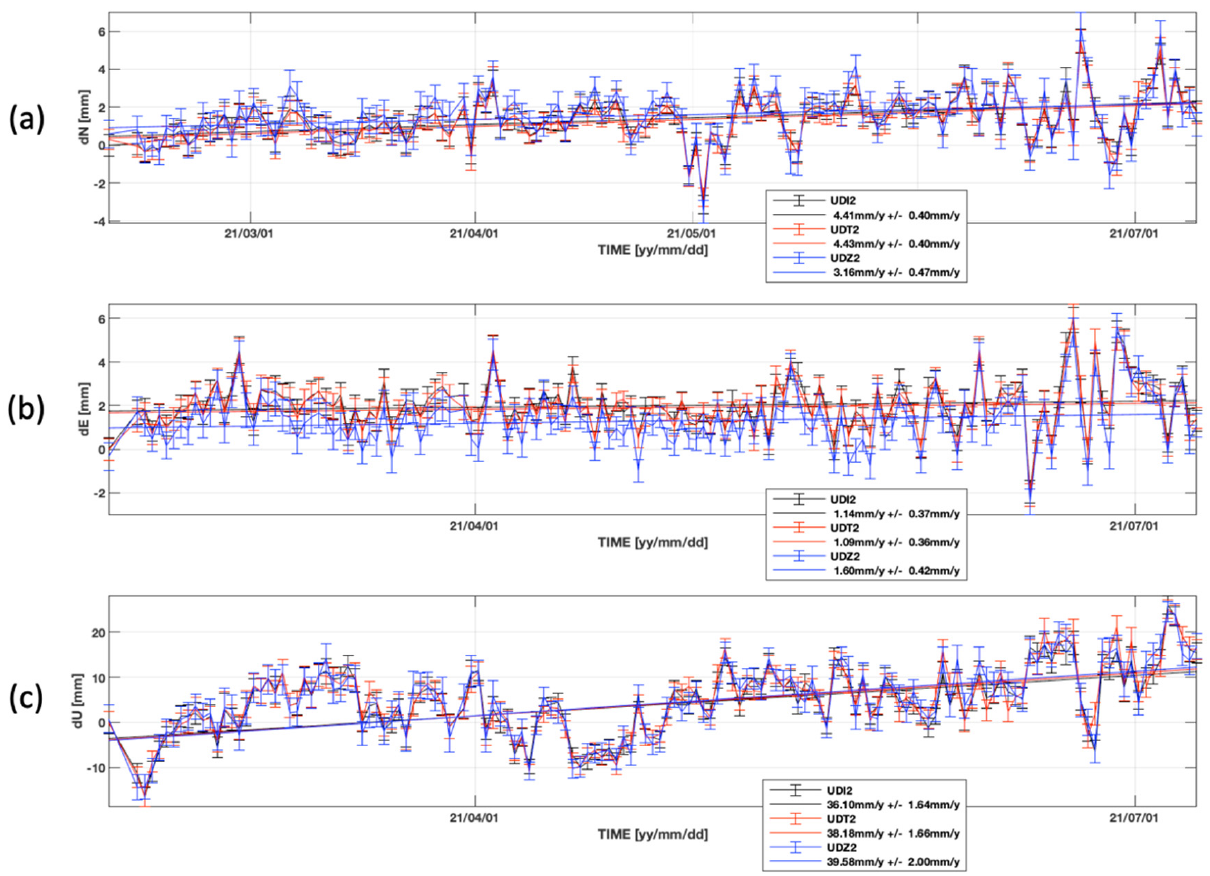
Figure 3. Time-series for MS stations in the considered time interval for the ( a ) North, ( b ) East, and ( c ) Up components of the displacement, with their linear trends overlapped (continuous lines). The starting point is the estimated position of UDI2 calculated using all available data since its installation in mid-2017. The color indicates the station: red and black indicate UDI2 and UDT2, equipped with top-quality Leica and Topcon receivers, respectively; blue represents the UDZ2, equipped with a low-cost GNSS receiver (u-blox). Error bars indicate the dispersion of the daily estimates.